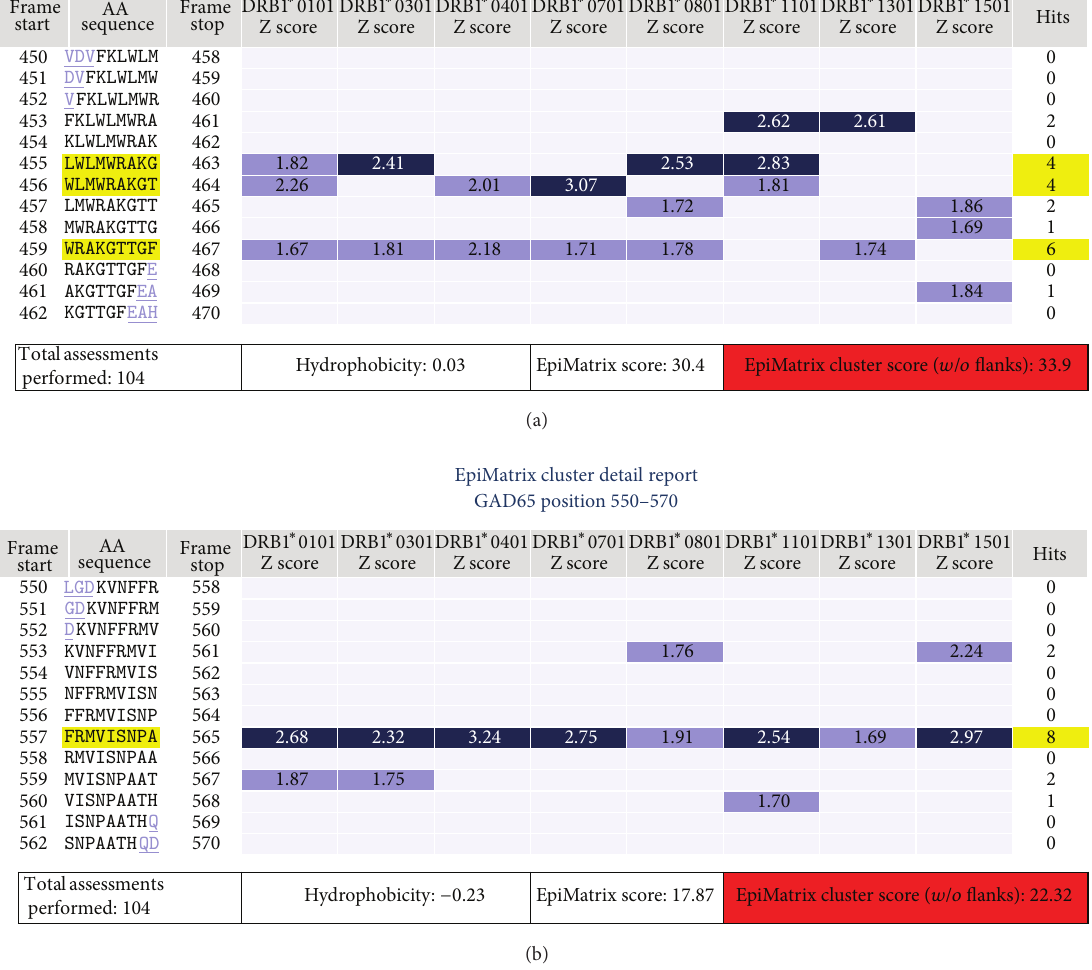
Figure 3: GAD65 450–470 and 550–570 cluster maps. EpiMatrix-predicted 9-mer hits for eight prevalent HLA class II alleles are shown in the cluster map under each allele for two example GAD 65 peptide sequences. Any 9-mer peptide scoring above 1.64 on the EpiMatrix “Z” scale (top 5%) is considered to be a potential epitope (blue bars) or “hit.” Peptides scoring above 2.32 on the scale (top 1%) are extremely likely to bind MHC (dark blue bars). The 450–470 cluster contains three 9-mers with multiple positive scores. Hits across four or more HLA class II alleles constitute an EpiBar. The GAD65 450–470 cluster contains three EpiBars; the 550–570 cluster contains a single EpiBar (highlighted in